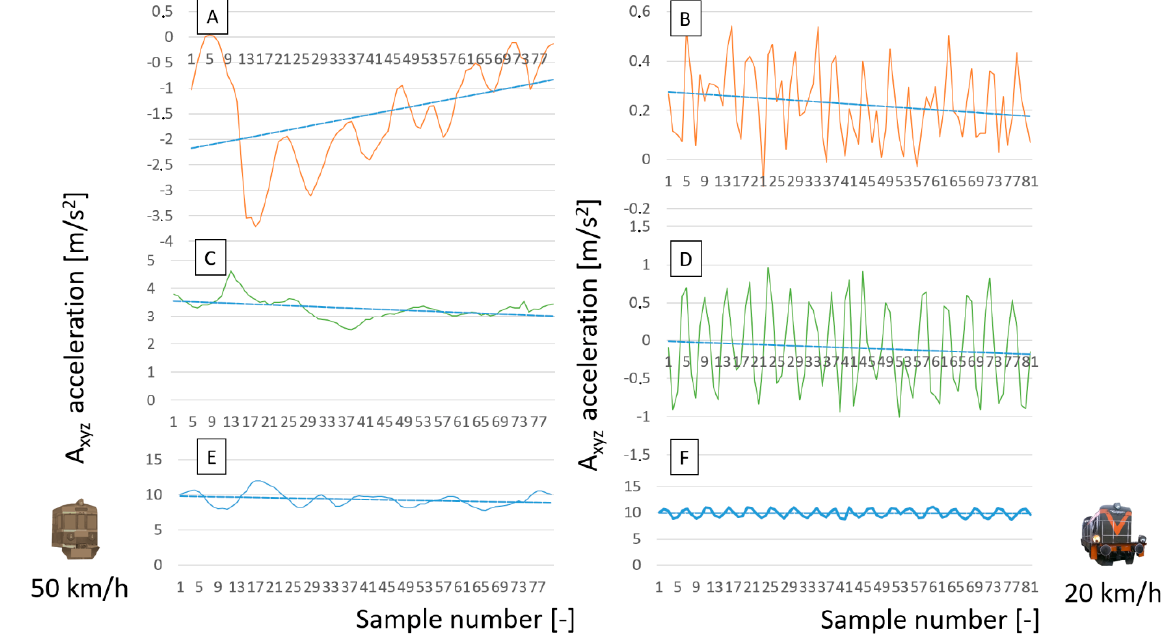
Figure 8. Selected examples of various vibrations experienced at various speeds and under different tasks: ( A , C , E ) Katowice Ligota station; ( B , D , F ) Chabówka station. Source: authors’ own materials. tasks: ( A , C , E ) Katowice Ligota station; ( B , D , F ) Chab ó wka station. Source: authors’ own These figures show the relationships between linear acceleration and infrastructure.